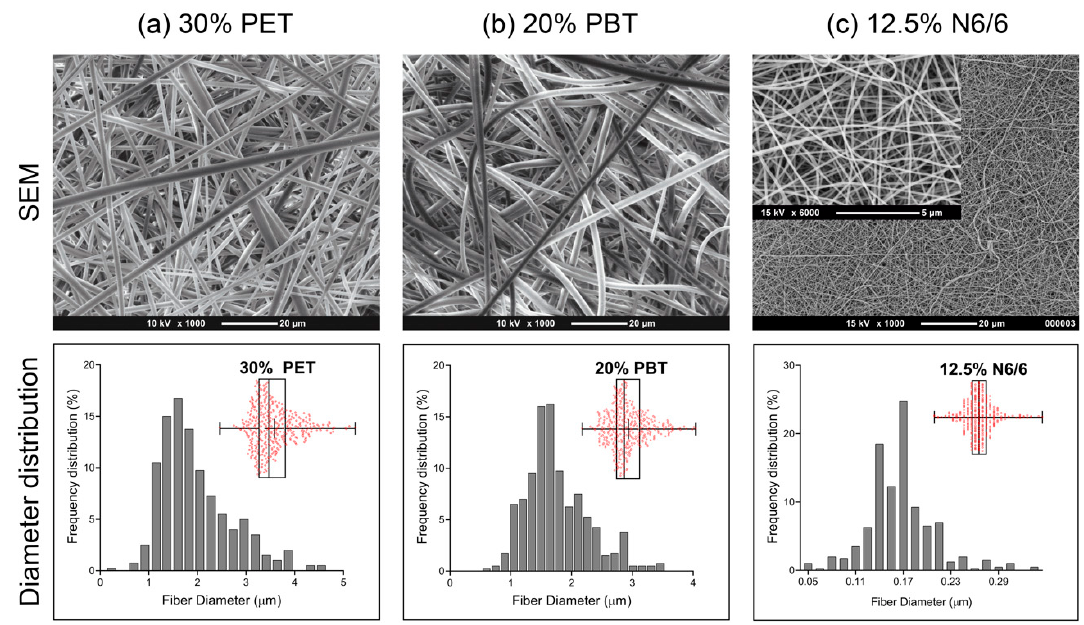
Figure 1. SEM micrographs and fiber frequency distribution of electrospun polymer mat surfaces. These images represent the characteristics of the meshes used in in vitro experiments. Full box plot analysis of ( a – c ) are shown in Figures S5–S7. Diameters were measured from eight SEM micrographs and analyzed from eight different locations on each mat (approximately 15 × 15 cm). A total of 400 measurements were taken (50 measurements from each image).